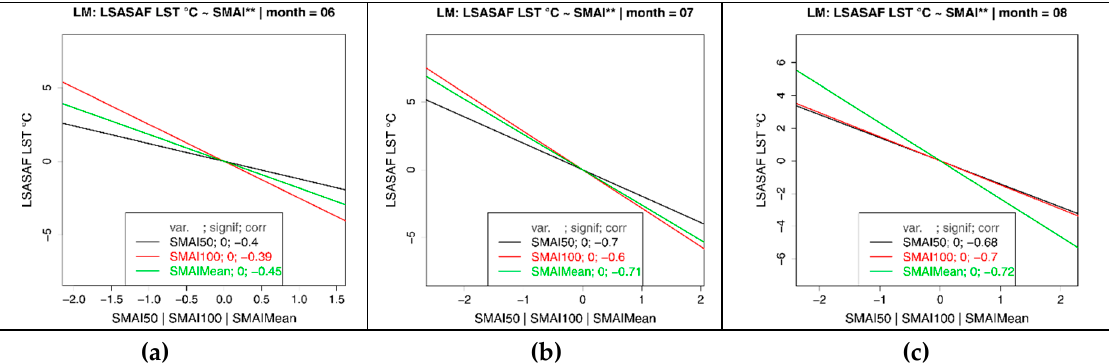
Figure 6. Negative linear regression models of the relationship between LSASAF LST anomalies and SMAI (for 50 cm, black; 100 cm, red; mean, green) for ( a ) June, ( b ) July, and ( c ) August over Bulgaria. The monthly mean (2007–2018) is used to calculate the anomalies.